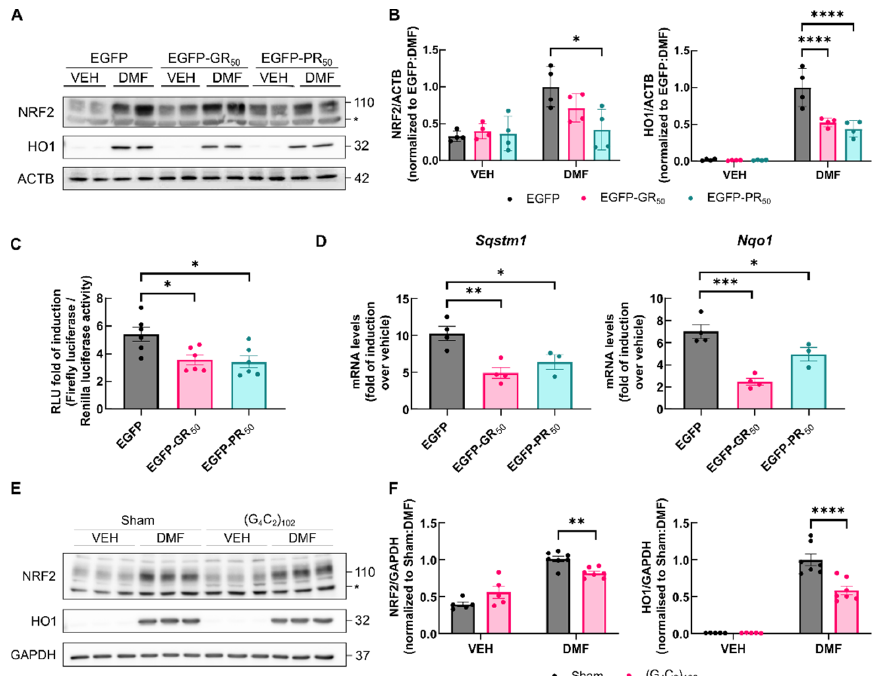
Figure 4. Pharmacological activation of NRF2-dependent transcription by dimethyl fumarate is impaired in EGFP-GR 50 , EGFP-PR 50 or (G 4 C 2 ) 102 expressing cells. ( A ) NSC34 cells were transiently transfected with EGFP, EGFP-GR 50 or EGFP-PR 50 for 48 h and treated with either VEH (DMSO 0.1%) or DMF 100 µ M over the last 16 h. ( A ) The levels of the indicated proteins were measured by performing an immunoblot analysis. ACTB levels were determined as a loading control. ( B ) Densitometric quantification for the immunoblots for NRF2 and HO1 presented in ( A ). ( C ) NSC34 cells were transiently co-transfected with EGFP, EGFP-GR 50 and EGFP-PR 50 and plasmids encoding for ARE-luciferase reporter and TK-Renilla luciferase for 48 h and treated as before. Fold of induction over vehicle in relative luciferase units is shown. ( D ) Fold of induction on mRNA levels of the Sqstm1 and Nqo1 genes in EGFP-DPRs transfected cells treated with DMF. mRNA levels were normalized using the geometric mean of the housekeeping genes Gapdh and Actb and to the non-induced control. ( E ) The expression of the sham cassette or the (G 4 C 2 ) 102 cassette was induced for 7 days with 1 µ g/mL tetracycline in NSC34 cells. In the last 16 h, cells were treated with either VEH (DMSO 0.1%) or DMF 100 µ M. The levels of the indicated proteins were measured by performing an immunoblot analysis. GAPDH levels were determined as a loading control. ( F ) Densitometric quantification for the immunoblots for NRF2 and HO1 presented in ( C ). Individual points in ( B , D ) represent the protein levels normalized by protein amount in each lane, bar height represents the mean of those protein levels in each group and error bars represent the SEM. Statistical analysis was performed with two-way ANOVA. Dunnett’s post-hoc test in ( B – D ). Bonferroni’s post-hoc test in ( F ). *, p < 0.05; **, p < 0.01; ***, p < 0.001; ****, p <